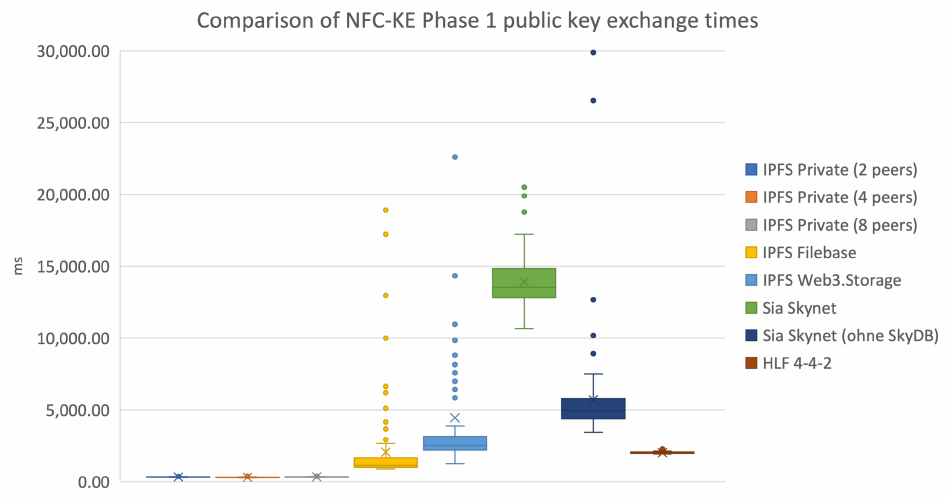
Figure 4. NFC-KE Phase 1 execution time